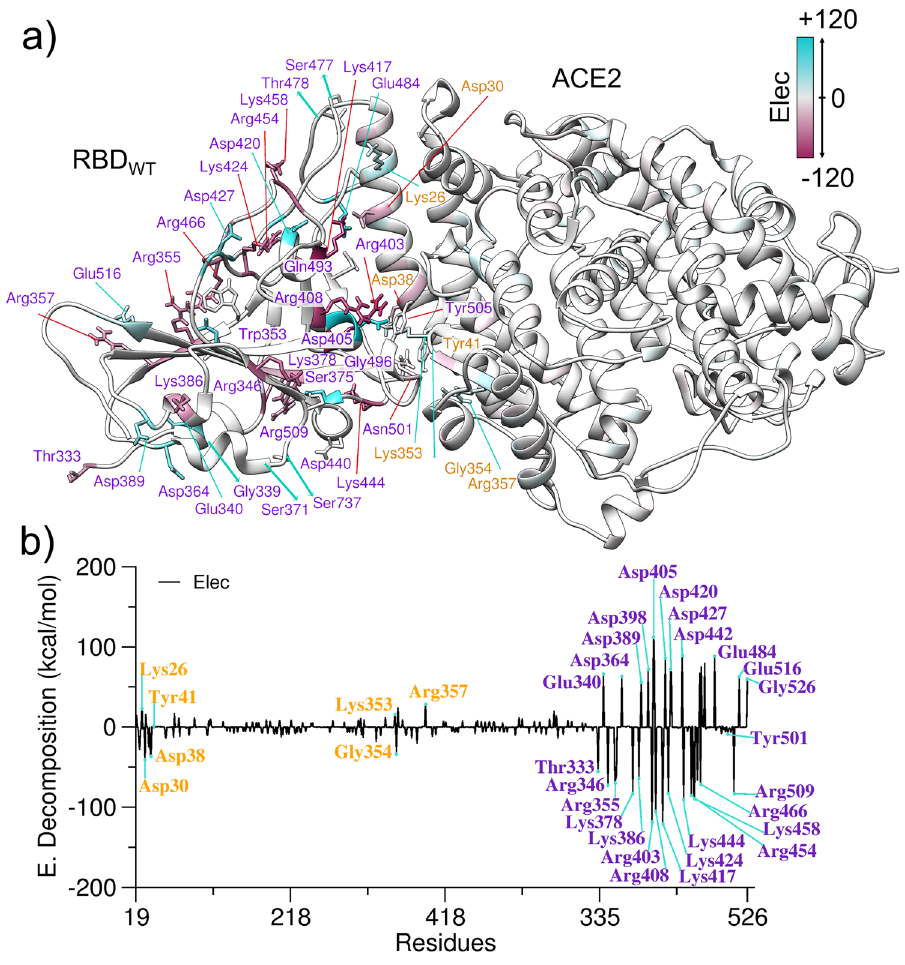
Figure 4. ( a ) Three-dimensional structure of the RBD WT and ACE2 complex with the electrostatic energy regions. ( b ) Decomposition energy per residue for the RBD WT system connected to ACE2. The label in orange is from the ACE2 region and in purple is from RBD.